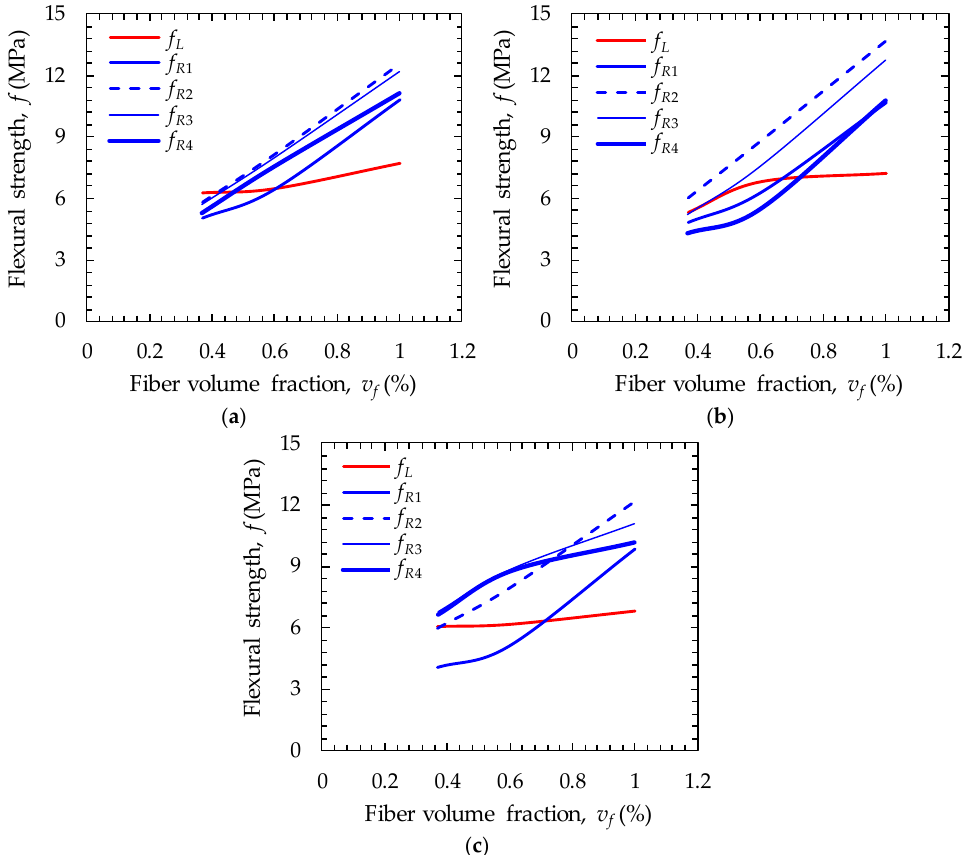
Figure 6. Relationship between flexural strength and fiber volume fraction: ( a ) 3D fiber, ( b ) 4D fiber, ( c ) 5D fiber.